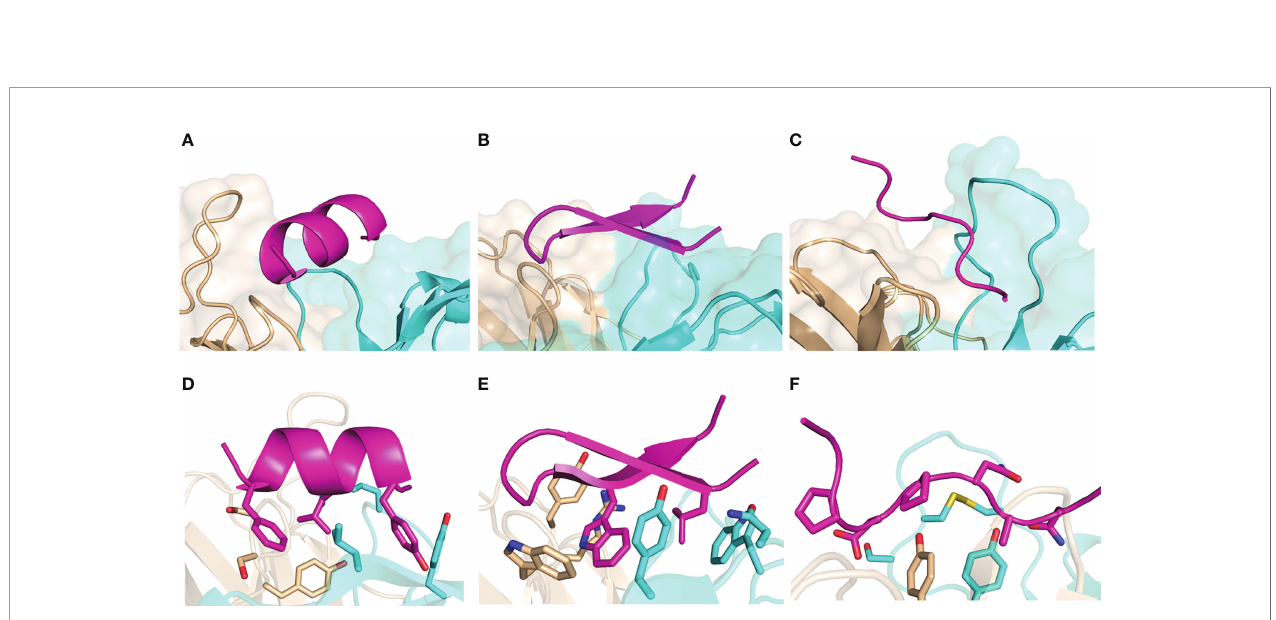
FIGURE 2 | Examples of peptide-antibody complexes and structural classes. (A, D) SARS-CoV-2 spike stem in complex with antibody B6 (PDB code 7M53; Helix peptide), (B, E) HCV E2 peptide in complex with antibody HCV1 (PDB code 4DGY; Hairpin peptide), (C, F) P. falciparum circumsporozoite protein junctional epitope in complex with mAb668 (PDB code 6PBV; Coil peptide). Antibodies are shown in cyan (heavy chain) and tan (light chain), and peptides are magenta. (D – F) show selected interface side chains as sticks, with oxygen atoms red, nitrogen atoms red, and sulfur atoms